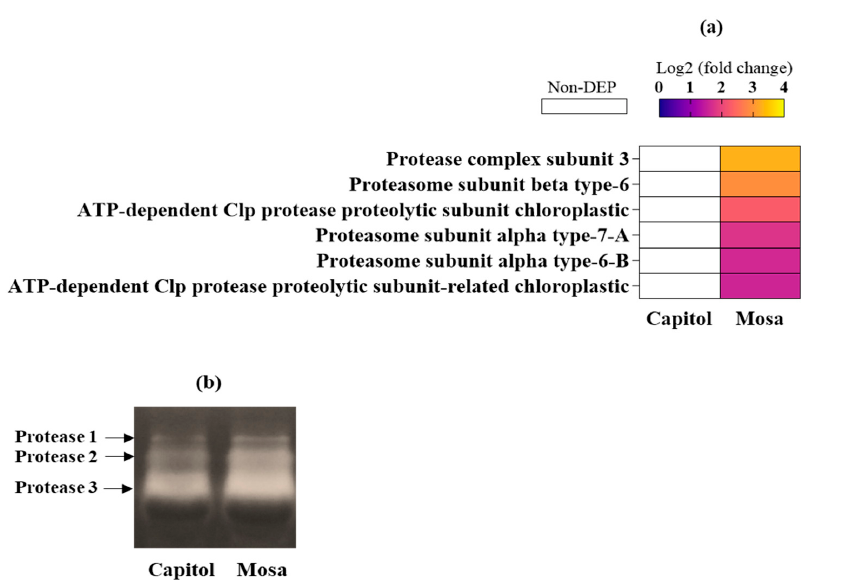
Figure 3. Differentially accumulated proteins involved in proteolysis in Brassica. napus cultivars (cv. Mosa) in responses to Xanthomonas campestris pv. campestris (Xcc). ( a ) Significantly expressed proteins (fold changes of ≥ 1.5 and ≤ 0.5 with p < 0.05, upregulated and downregulated, respectively) are presented as Log2 fold changes (Xcc/Non-Xcc). DEP—differentially expressed protein; ( b ) in-gel staining of protease activity in resistant cultivar (cv. Capitol) and susceptible cultivar (cv. Mosa) proteins in responses to Xanthomonas campestris pv. campestris